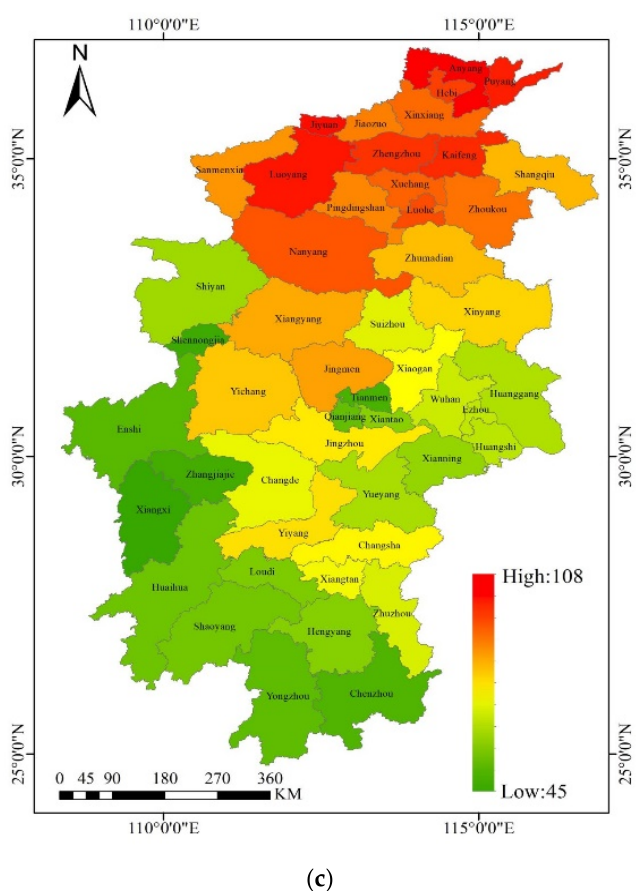
Figure 2. Annual average AQI changing trend in every province from 2017 to 2019: ( a ) Henan Province, Hubei Province and Hunan Province in 2017; ( b ) Henan Province, Hubei Province and Hunan Province in 2018; ( c ) Henan Province, Hubei Province and Hunan Province in 2019.